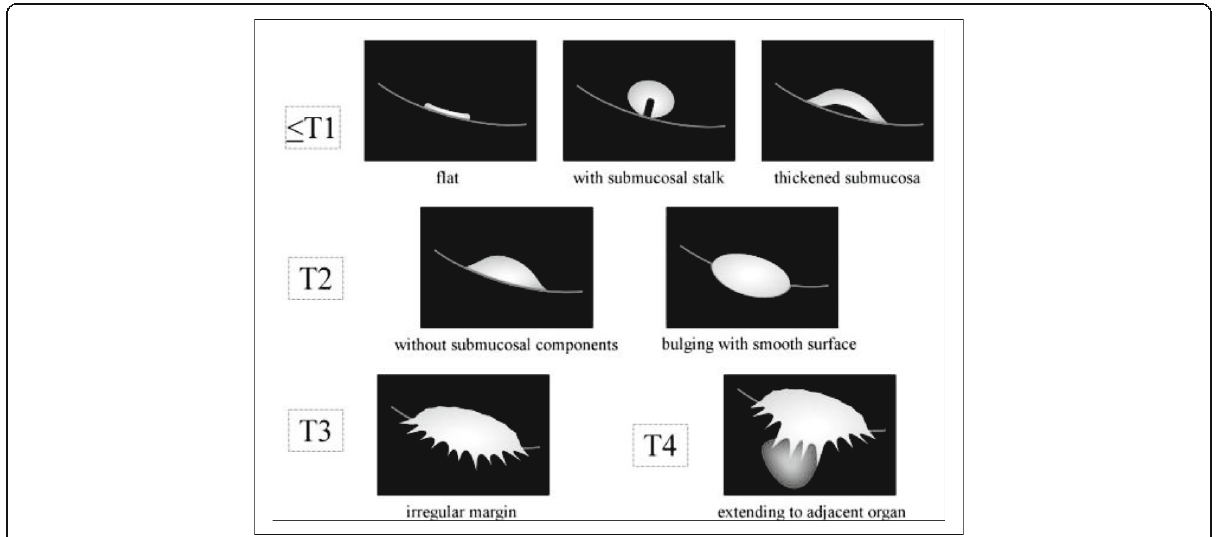
Fig. 1 Diagram shows diagnostic criteria for using DW imaging for staging bladder cancer. Cancer component, muscle layer, and submucosa show high, intermediate, and low SI, respectively. Submucosal stalk or thickened submucosa indicates T1 or lower stage; smooth tumor margin without submucosal components, T2; irregular margin toward the perivesical fat tissue, T3; and extension into adjacent organs, T4 [9]